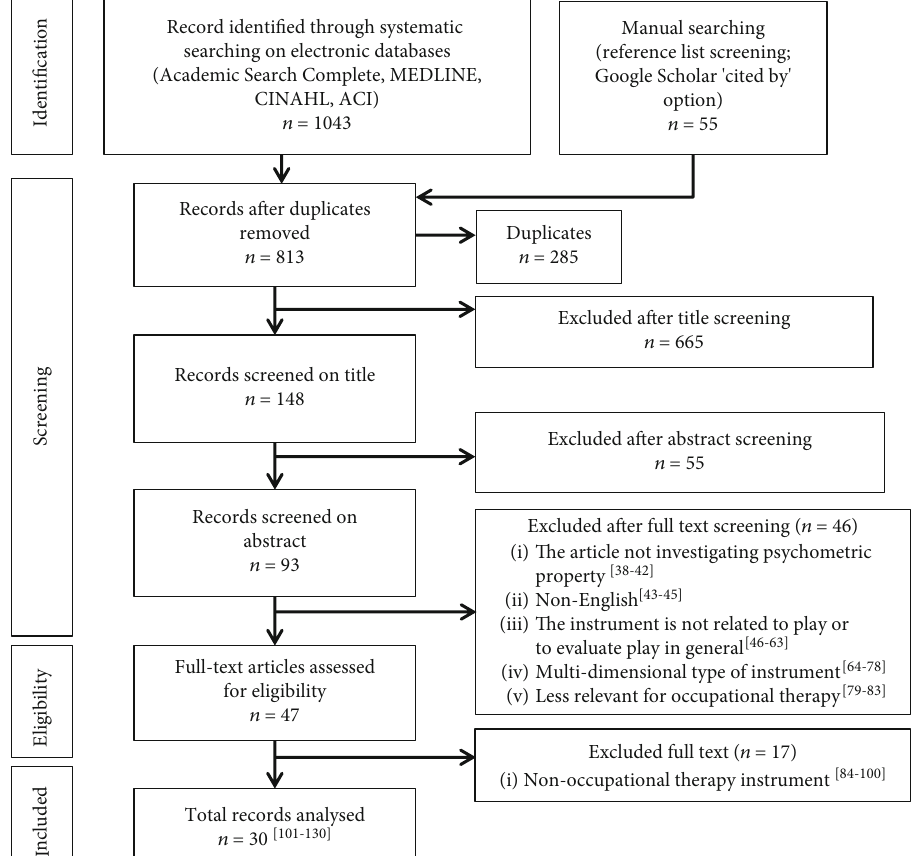
Figure 1: Screening